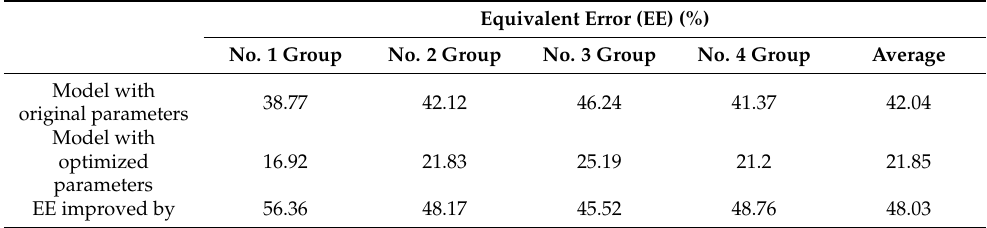
Table 3. Equivalent error analysis of the models with original and optimized